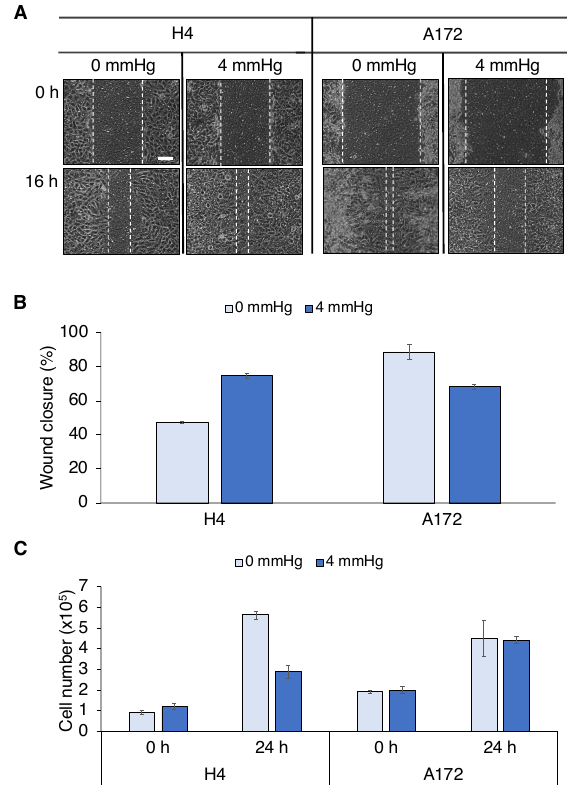
Figure 1. Effects of mechanical compression on glioma cell lines. ( A ) Wound closure assay performed on two different glioma cell lines (H4 and A172 cells). Cancer cells are seeded on the inner chamber of a transwell insert, on the top of which an agarose cushion is positioned. A piston with adjustable weight applies a solid stress (4 mmHg) on the cells and the effects of compression are visualized after 16 h (scale bar: 0.1 mm). ( B ) Quantification of wound closure at 16 h. For H4 cells, compression increases their migratory behavior, leading to a higher wound closure percentage. On the other hand, A172 cells display higher migratory potential in the control case (0 mmHg), but respond to compression by reducing migration on the substrate. ( C ) An Alamar Blue assay is performed on H4 and A172 cells before and after (24 h) mechanical compression (4 mmHg) as an indicator for total cell number in the transwell insert. While compression reduces the number of H4 cells, no influence on replication is observed for A172 cells. In ( B and C ) error bars show standard